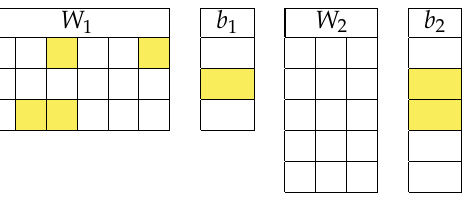
Table 5. Results of the magnitude pruning algorithm—colored boxes are removed synaptic connec- tions or